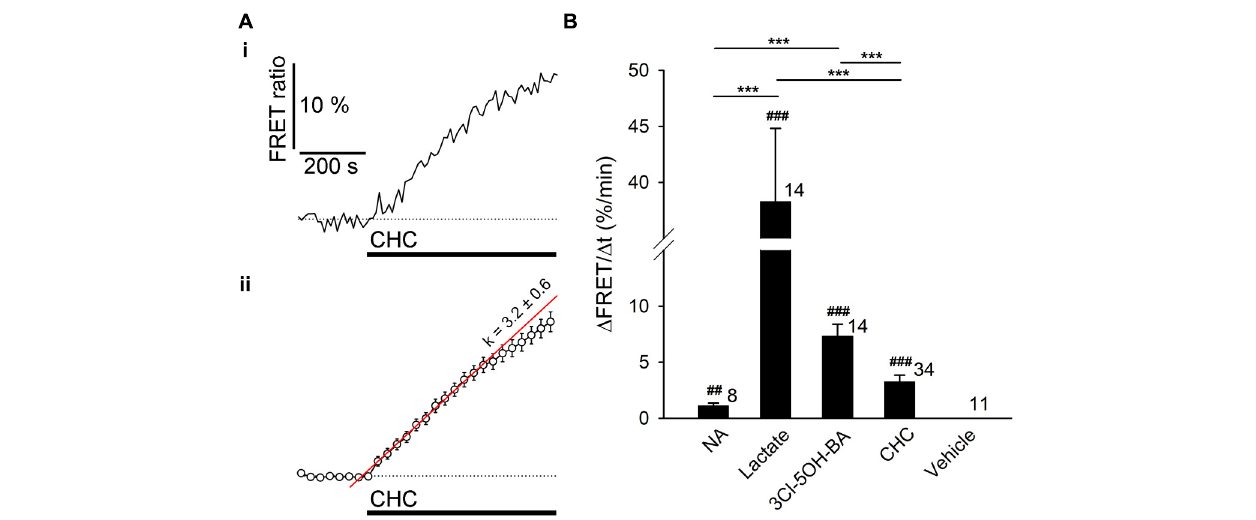
FIGURE 6 | The resting rate of glycolysis and lactate production is modulated by noradrenaline and 3Cl-5OH-BA in astrocytes. (A) Representative (i) and mean (ii) time-course of Laconic FRET ratio signal upon addition of 6 mM CHC. Data are expressed as the percentage of the FRET ratio signal (mTFP/Venus) relative to the baseline ratio values. Note that the increased FRET ratio indicates an increase in [lactate] i . Each data point in (ii) represents mean ± s.e.m. The initial rate of change in [lactate] i was determined by fitting the regression lines to the initial rise of the curves. The regression line in (ii) has the form of: (cid:49) FRET (%) = k (%/min) × (cid:49) t (min) + (cid:49) FRET 0 , where t is time, (cid:49) FRET 0 is (cid:49) FRET at the time of stimulus, and the k -slope is the initial (cid:49) FRET rise: k = 3.2 ± 0.6 %/min. (B) Comparison of mean maximal initial rates in FRET ratio changes ( (cid:49) FRET/ (cid:49) t ) upon the addition of NA (200 µ M), L -lactate (20 mM), 3Cl-5OH-BA (0.5 mM), CHC (6 mM), and vehicle (control) in astrocytes. Maximal initial rates are expressed as percent change of FRET ratio per minute. Numbers by the error bars depict the number of cells analyzed. ∗∗∗ P < 0.001 one-way ANOVA comparison between different types of stimuli; ## P < 0.01, ### P < 0.001 one-sample t -test. Data for every set of experiment was acquired from at least two different